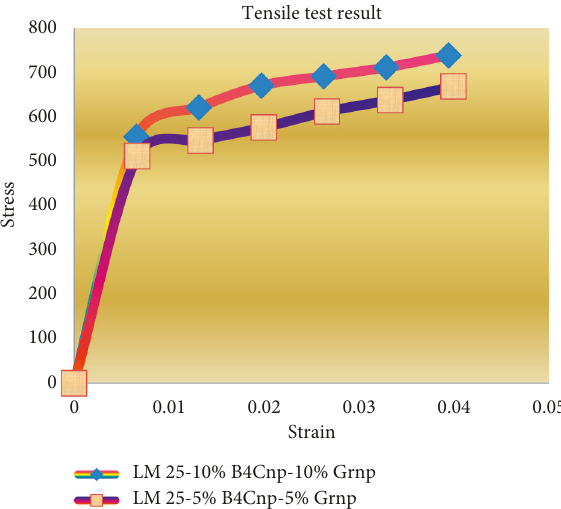
4 Cnp-Grnp hybrid